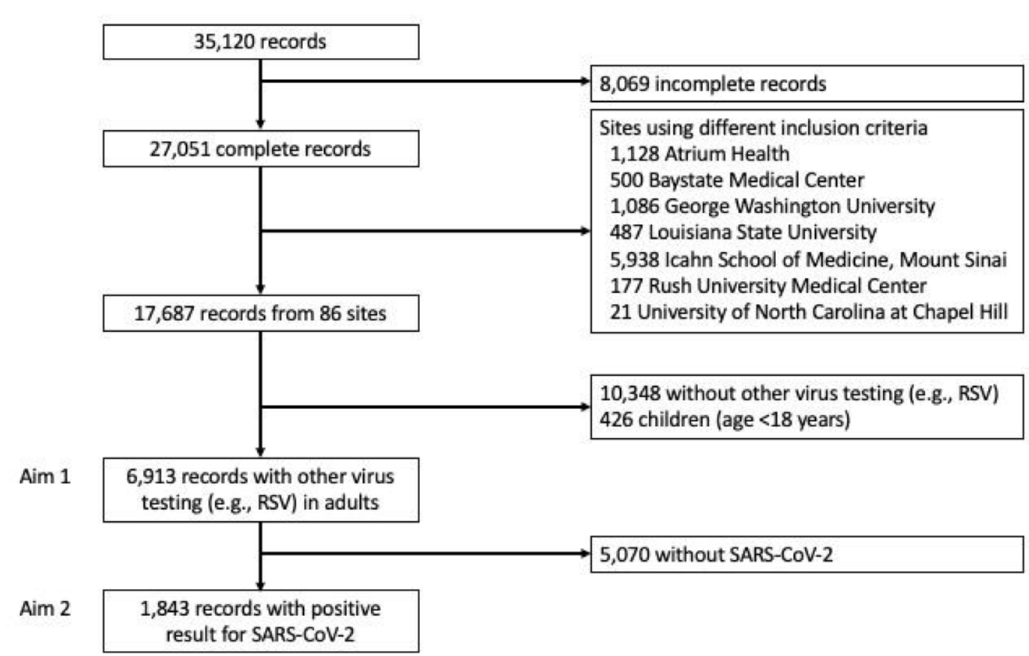
Figure 1. Inclusion flow